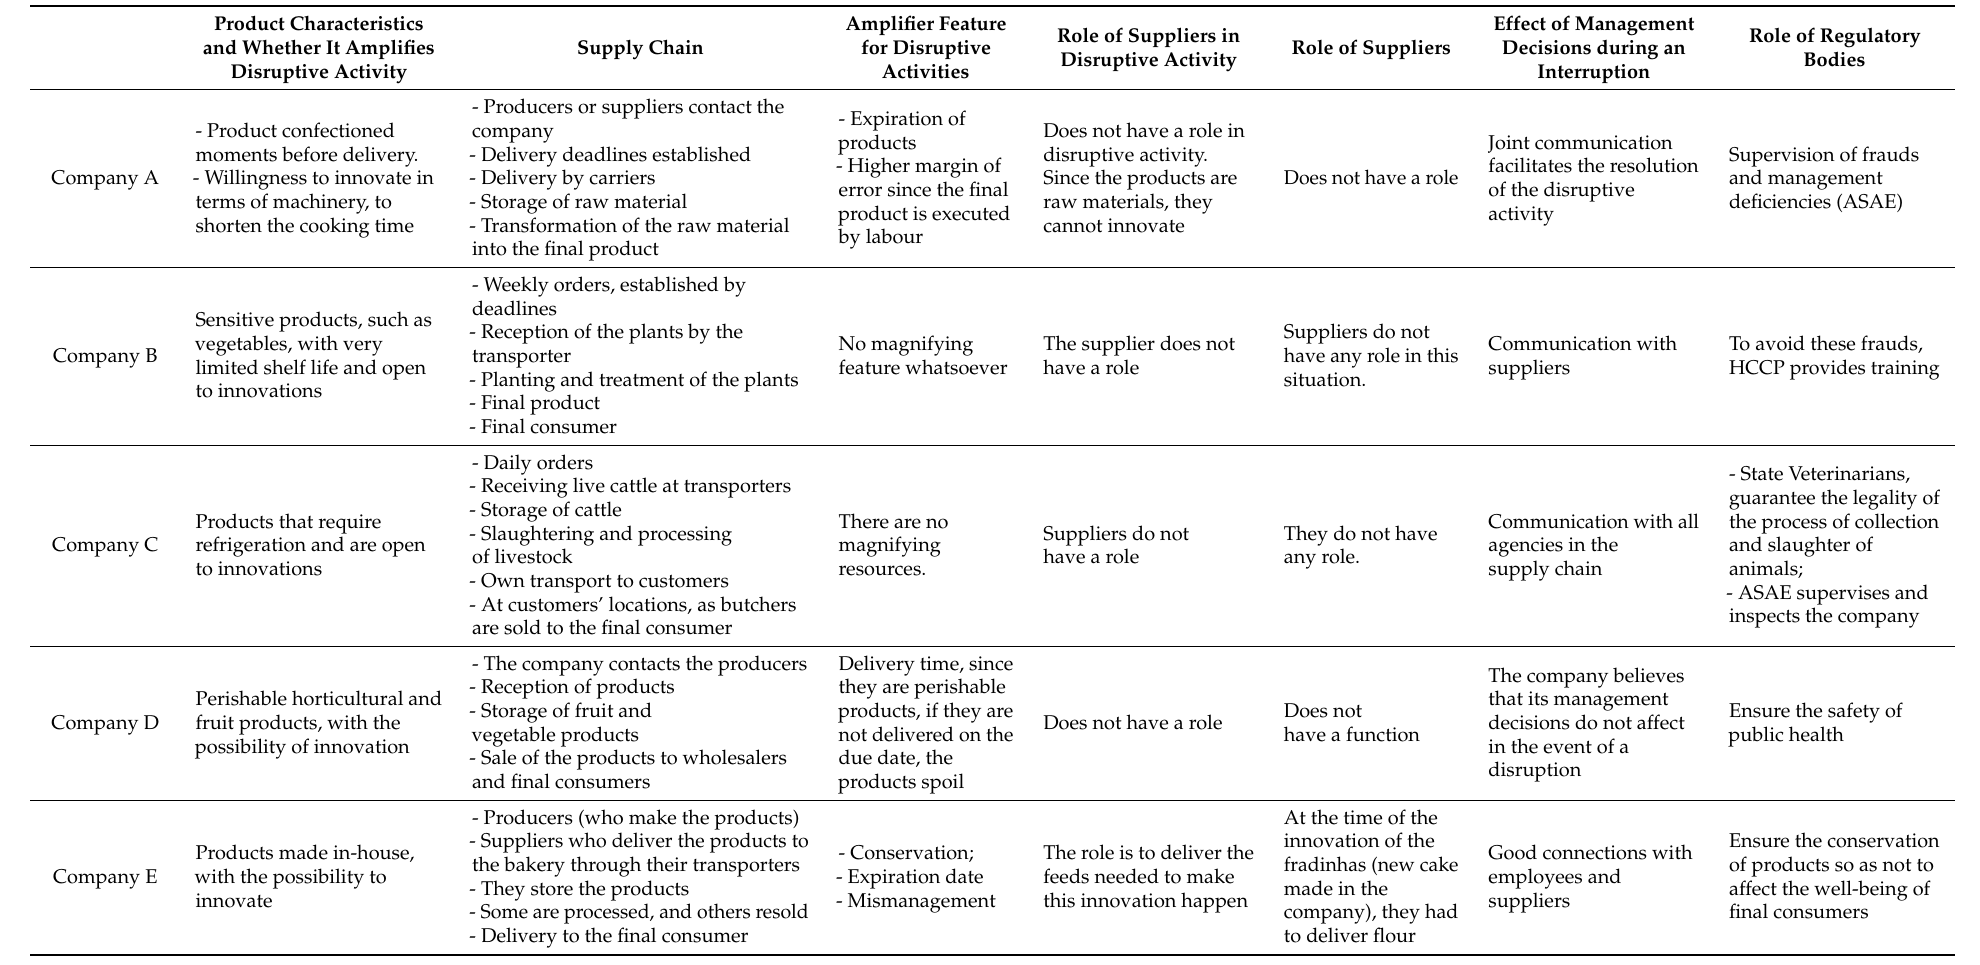
Table 4. Summary of results of supply chain